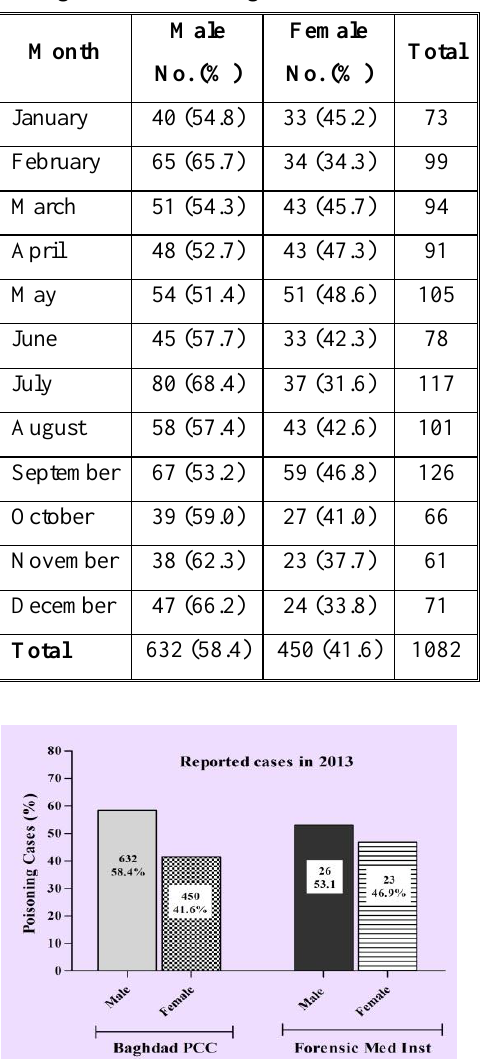
Table (1): Distribution of poisoning cases according to gender and month of the year in Baghdad PCC during 2013.